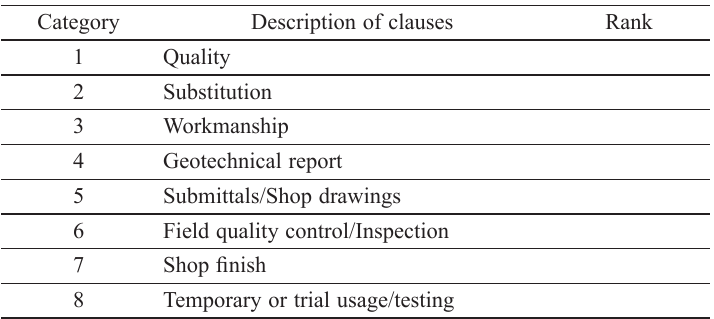
Table 1 . Ranking of categories in Appendix 2